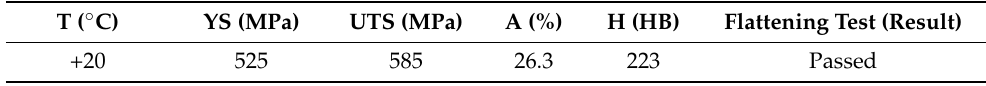
Table 3. Mechanical properties of the P91 tube batch.